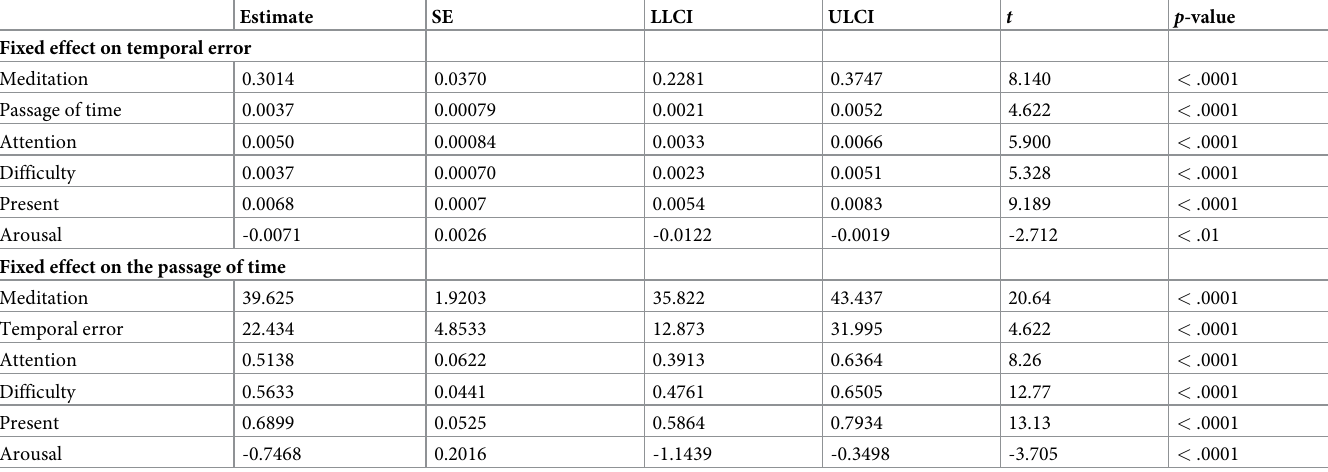
Table 4. Fixed effect of judgments on the temporal standardized error or the passage of time judgment using the Linear mixed model. Estimate SE LLCI ULCI t p -value Fixed effect on temporal